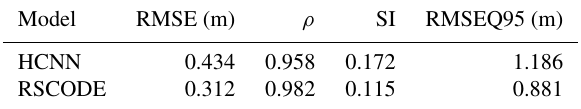
Table 3. Scores of H s prediction by HCNN at station no. 62001. Buoy H s is taken as the